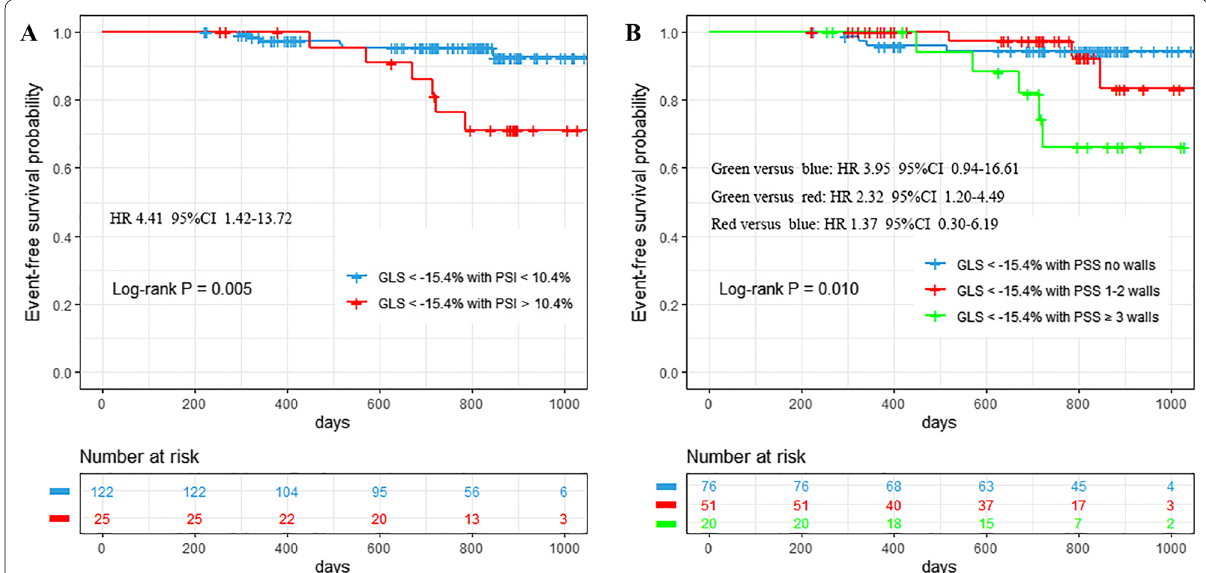
Fig. 4 Event-free survival. Kaplan–Meier survival curves for adverse events prediction in patients with stratification of GLS > 15.4% by ( A ) GLS; ( B ) the number of left ventricle walls with PSS. GLS: global longitudinal strain; PSI: post-systolic index; PSS: post-systolic